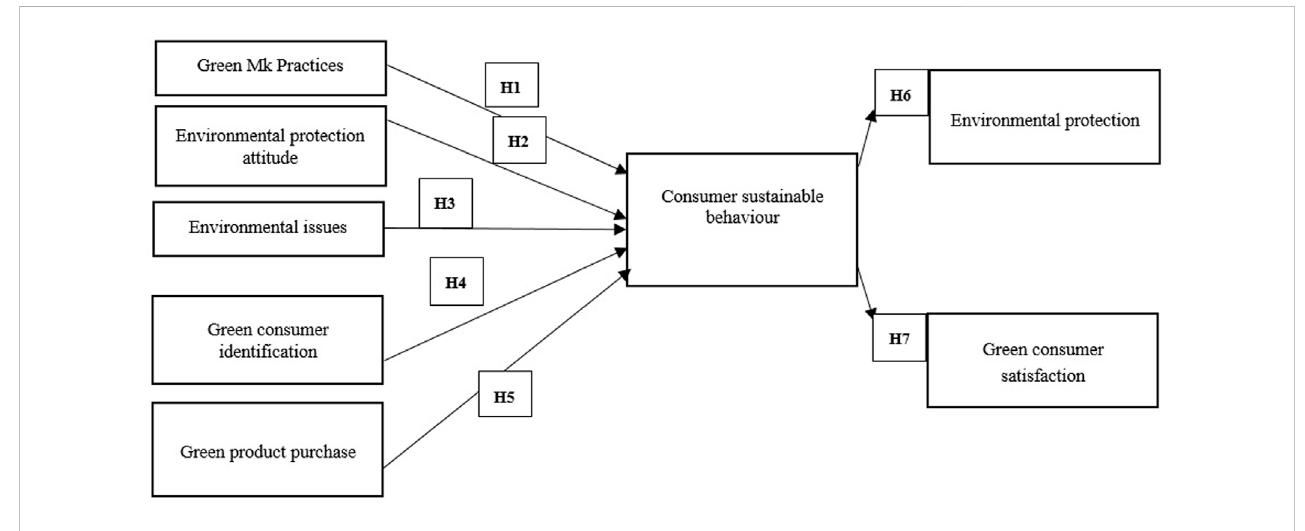
FIGURE 1 Theoretical model regardingthe green consumer ’ s pro fi